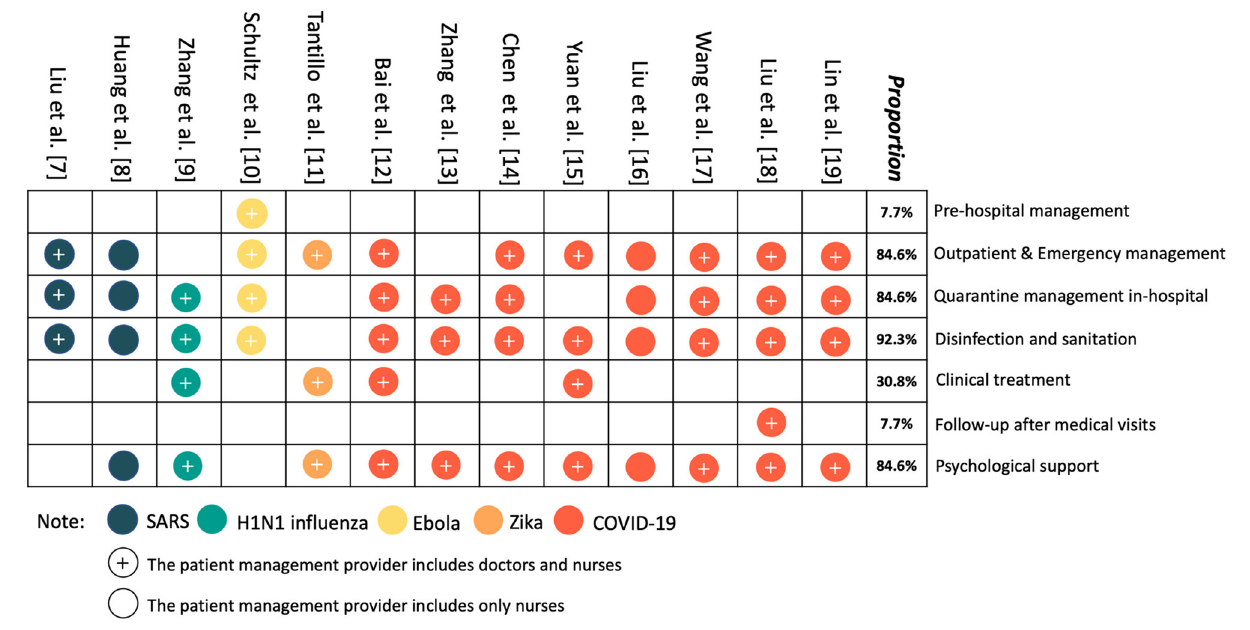
FIGURE 3 | The evidence map of patient management research on major public health